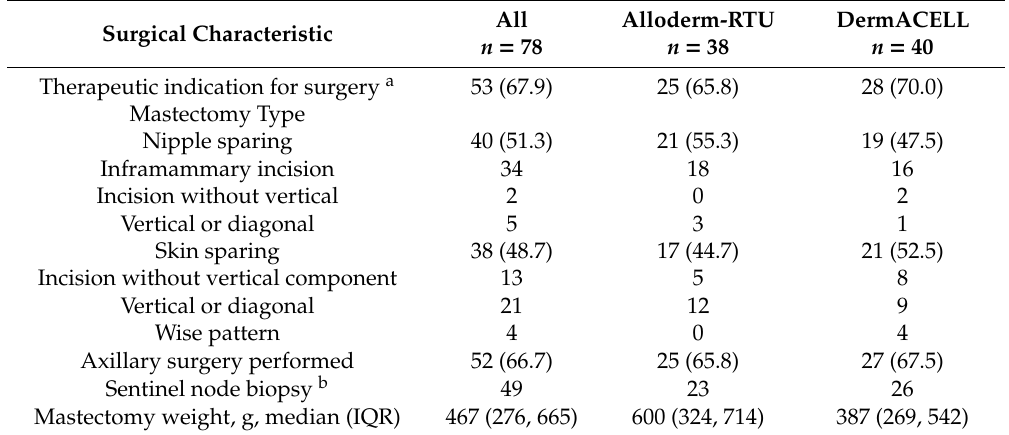
Table 2. Surgical characteristics. All values are number (percentage) unless otherwise